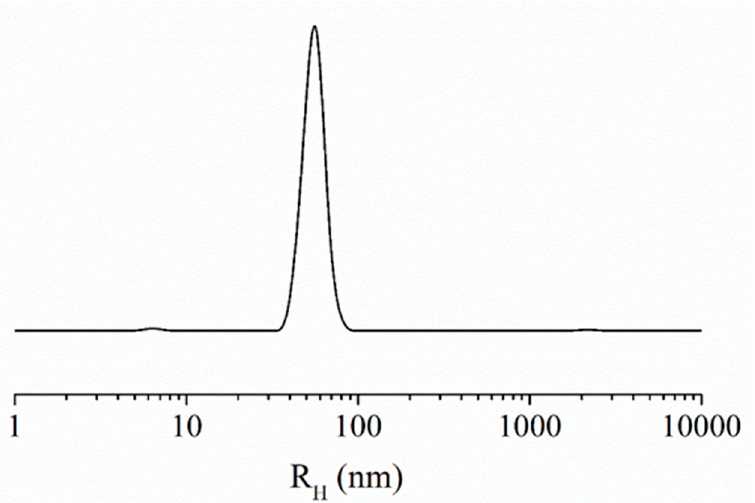
Figure A1. Hydrodynamic radius distribution function obtained through dynamic light scattering (DLS) measurements for the HoThyRu/DOTAP nanoformulation at 30:70 molar ratio. After preparation as described in Material and Methods (2.1. Preparation of HoThyRu/DOTAP formulation) and in [22] (Biomacromolecules 2013; 14(8): 2549 – 2560), liposomes were subjected to DLS control prior to the use in preclinical trials. The hydrodynamic radius for the nanosystem HoThyRu/DOTAP is located in the range 70–100 nm, which is the typical range of unilamellar vesicles.